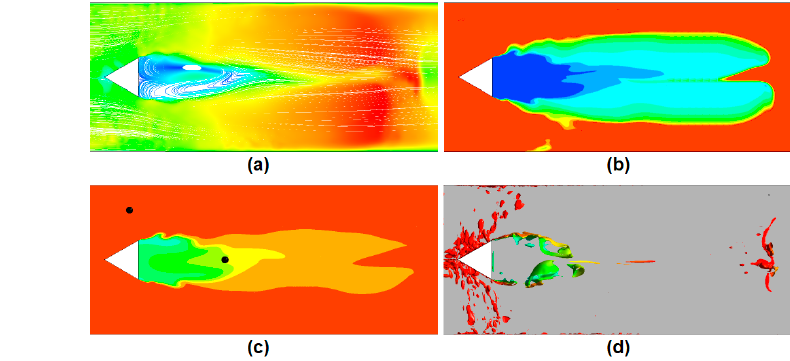
Figure 4. Cavitation at test section mid-plane, σ = 2.221. ( a ) Vector lines; ( b ) distribution of water volume fraction; ( c ) distribution of temperature; ( d ) vortical structures behind the cylinder (Q criterion) colored with temperature.